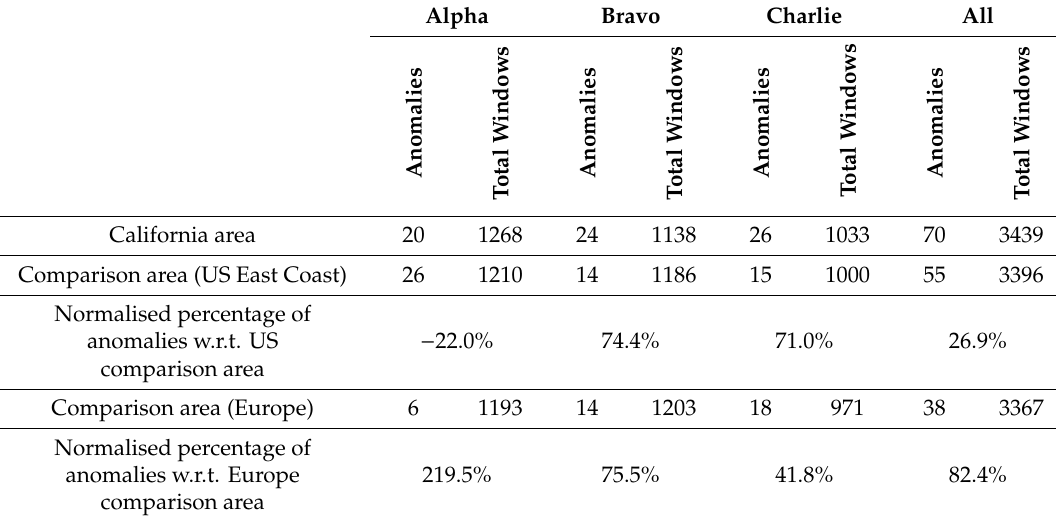
Table 1. Number of anomalies, total windows and normalised percentage of anomalies detected in the epicentral area with respect to (w.r.t.) the comparison areas centred in US East Coast and in Europe, using the Swarm satellites. The anomalies have been obtained by considering 1000 days before the California earthquake that occurred on 6 July 2019. Alpha Bravo Charlie